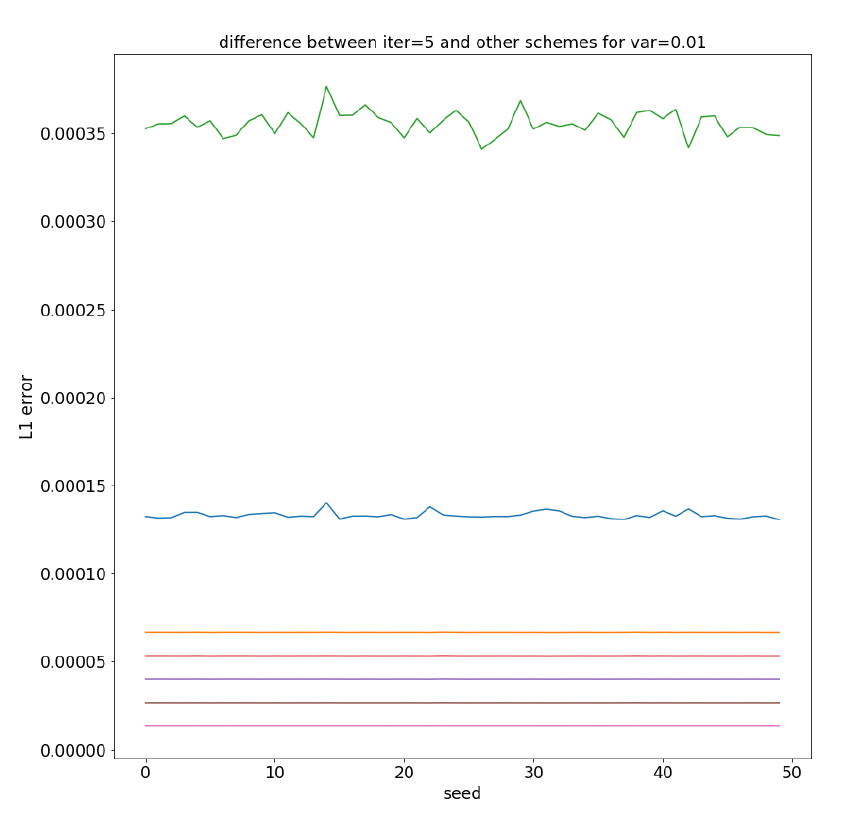
Figure 5. For the experiments, we have applied the L 1 -error given in Equation (74) and apply the iterative splitting approach with i = 5 as reference solution. For the variance of the W ( t ) stochastic process, we used E 2 ( ∆ W ) = 0.01. In the figure, we have the highest error for the AB-splitting approach, then the ABA-splitting approach and the lowest errors are given with the iterative splitting approach with i = 1, . . .